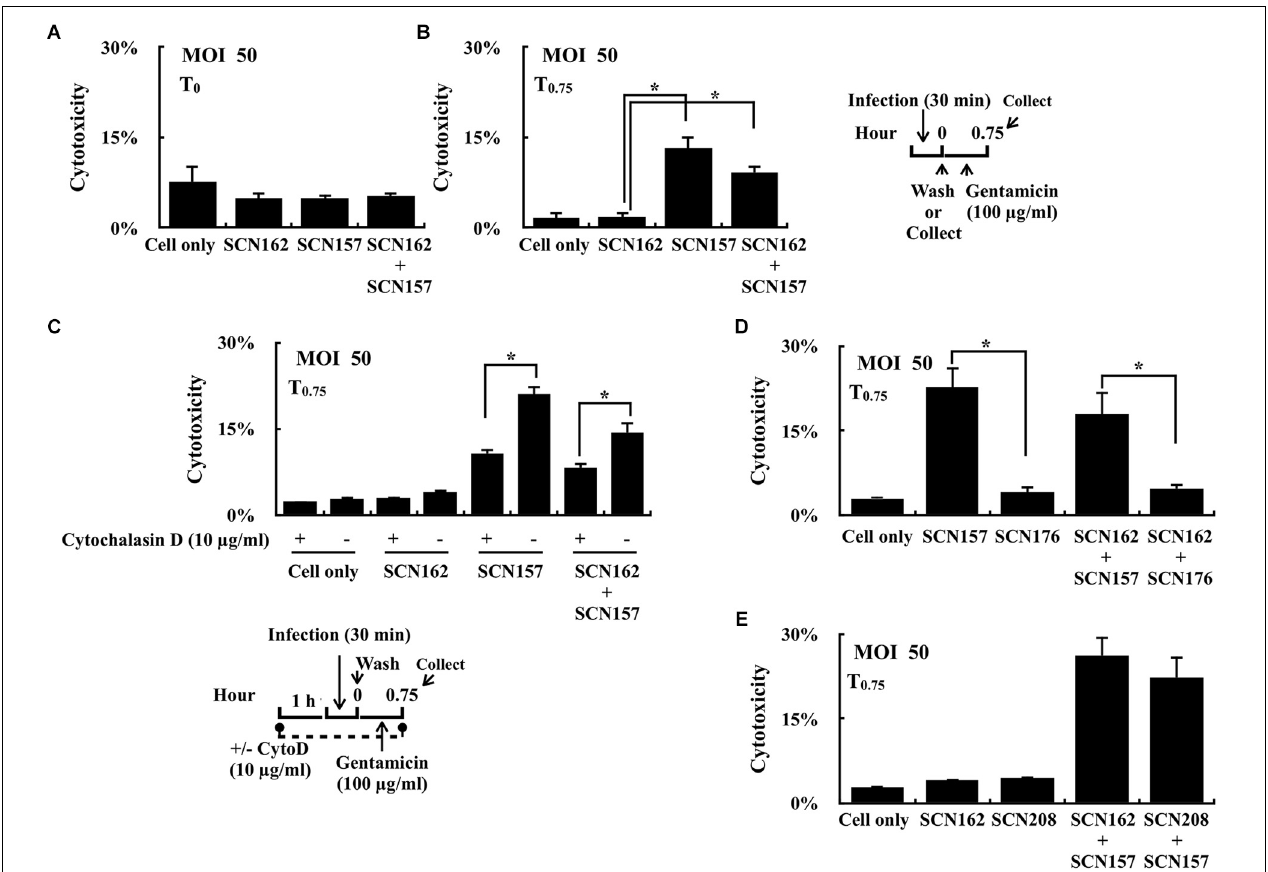
FIGURE 3 | Cytotoxicity of the capsule-deficient A20 and AP3 (SCN162 and SCN157, respectively), SpeB C192S mutant of SCN162 (SCN208), and slo mutant of SCN157 (SCN176) on PMA-activated U937 cells with or without cytochalasin D during infection. (A,B) Cytotoxicity of SCN162 and SCN157 on PMA-activated U937 cells after 0.5 h (T 0 ) and 0.75 h (T 0 . 75 ) of infection. The right panel shows the infection protocol of (A,B,D,E) . (C) Cytotoxicity of SCN162 and SCN157 on PMA-activated U937 cells with or without cytochalasin D (CytoD) treatment. The lower panel shows the infection protocol. (D,E) Cytotoxicity of SCN162, SCN157, SCN176, and SCN208 on PMA-activated U937 cells. Error bars represent the standard deviations. ∗ p < 0.05.